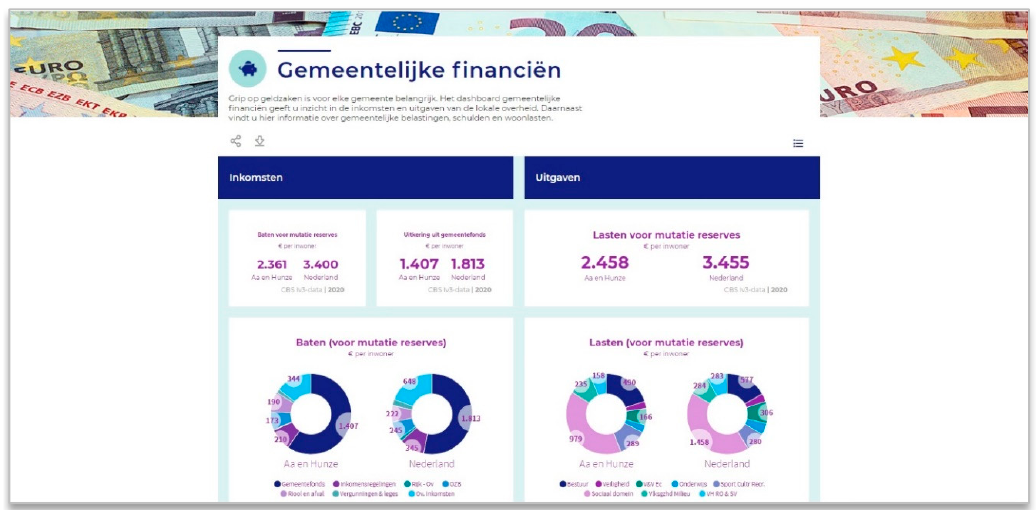
Figure 7. Waarstaatjegemeente.nl browser displaying municipality finances. Retrieved from: https://www.waarstaatjegemeente.nl/dashboard/gemeentelijke-financi%C3%ABn.